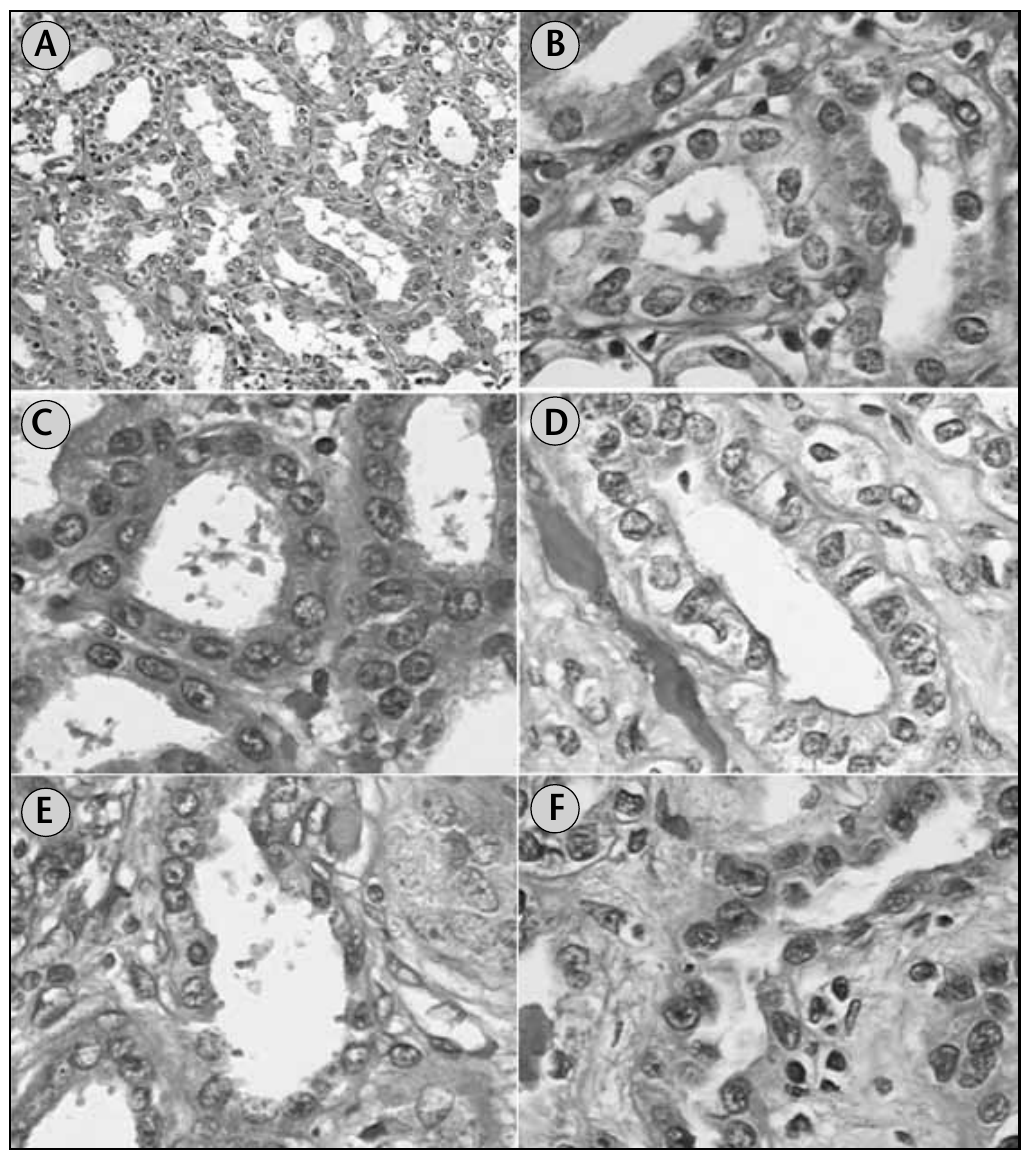
Figura 1 – DIETR: avaliação morfológica por HE (a) Área displásica, panorâmina, objetiva de 10×; (b a F) alterações morfológicas da DIETR – aumento da relação núcleo: citoplasma, nucléolo evidente, binucleação e hipercromasia, objetiva de 40× HE: hematoxilina-eosina; DIETR: displasia intraepitelial tubular